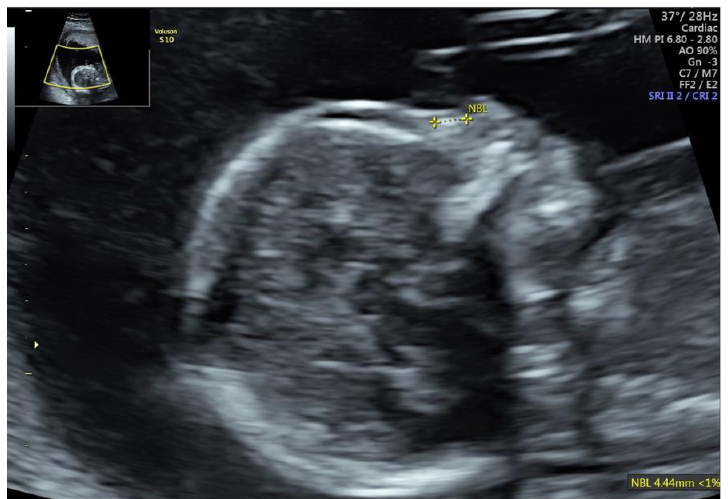
Figure 3. Fetus with tetrasomy